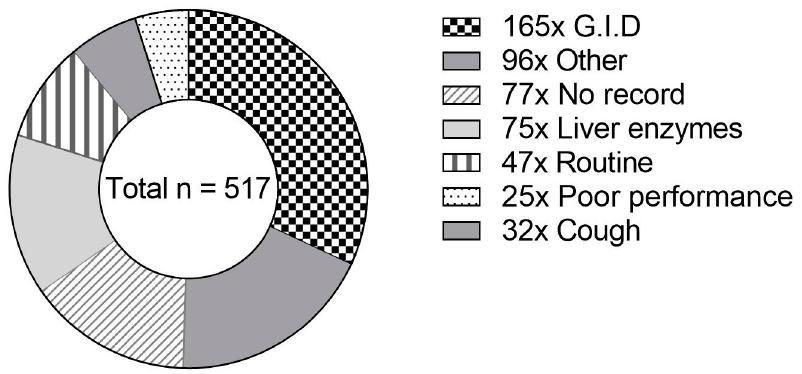
Figure 2. Proportional frequency of preliminary records given by horse owners for submitted concentrate samples ( n = 517). GIDs—gastrointestinal disorders ( n = 165): colic ( n = 150);